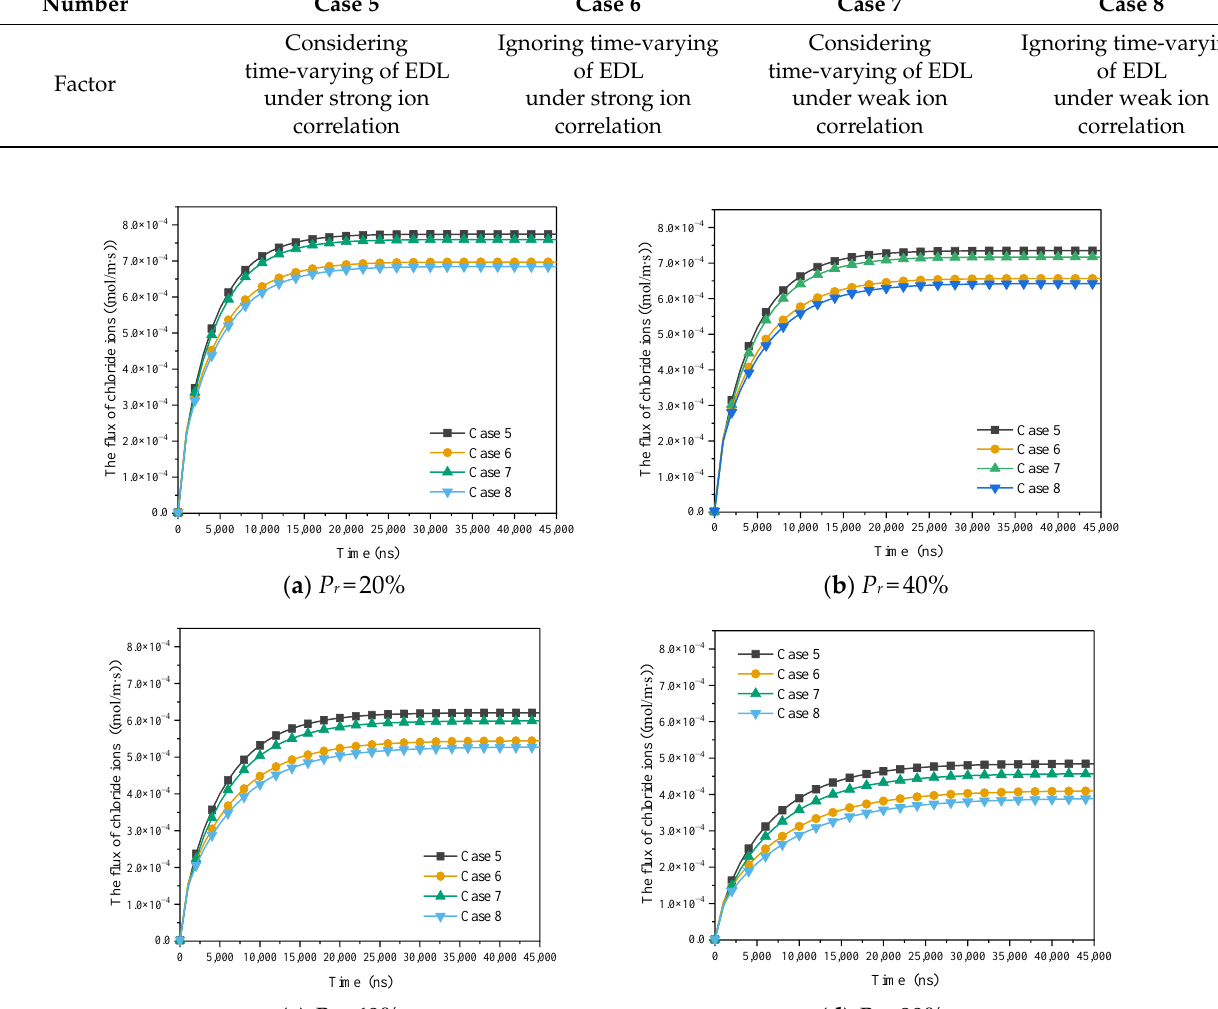
Figure 15. The influence of EDL time-varying on diffusion flux at steady state at micron scale. From the above discussion of the research results, it can be seen that the heterogene- ity of C-S-H has an influence on the interfacial effect. In order to quantify further the var- iation of different interface effects with the change of C-S-H homogeneity, the concept of contribution ratio C was introduced. The molar flux ignoring the interface effects were set as 𝐹 𝑖 and the flux considering the interface effects were set as 𝐹 𝑐 . The molar flux considering all the factors, ignoring slippage and ignoring EDL time- varying were set as 𝐹 𝑐𝑎 , 𝐹 𝑖𝑠 , 𝐹 𝑖𝐸 , respectively. The contribution ratio of slippage ( 𝐶 𝑠 ) can be expressed as ca